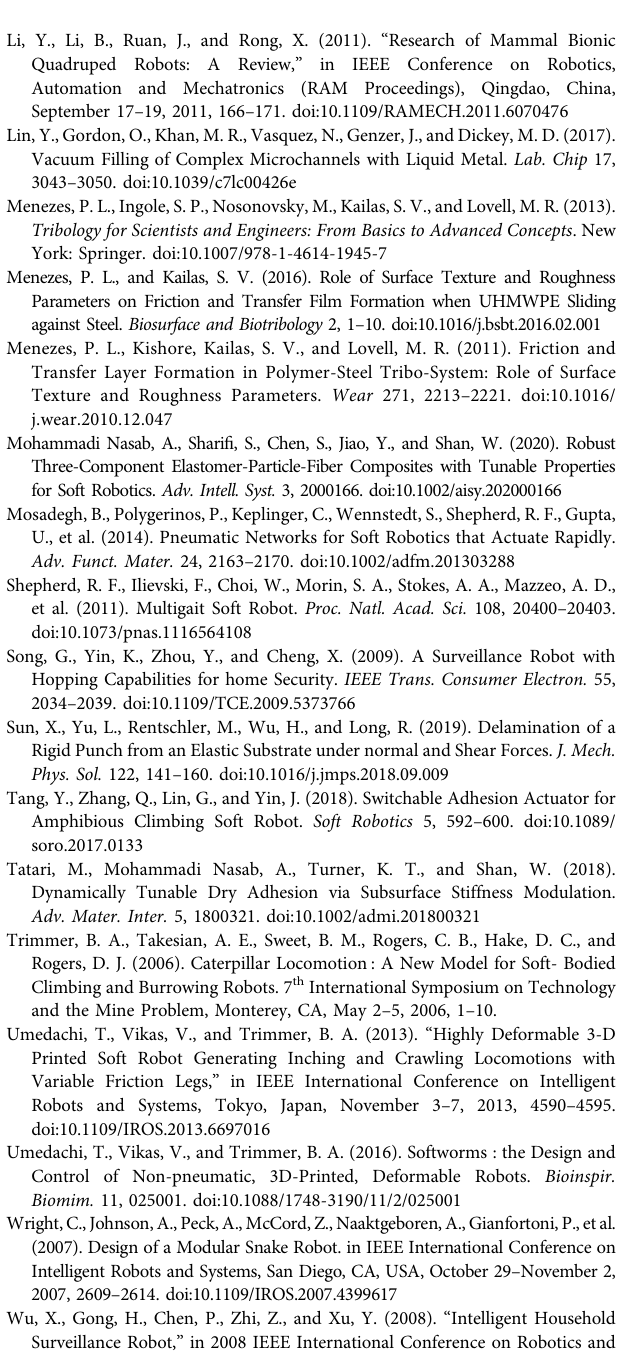
Supplementary Figure 1 | The CoFs of the de-activated and activated composite pads from simulations. The normal force is kept as 0.951 N while the shear stress limit is 0.3 MPa for panel A and 0.4 MPa for panel